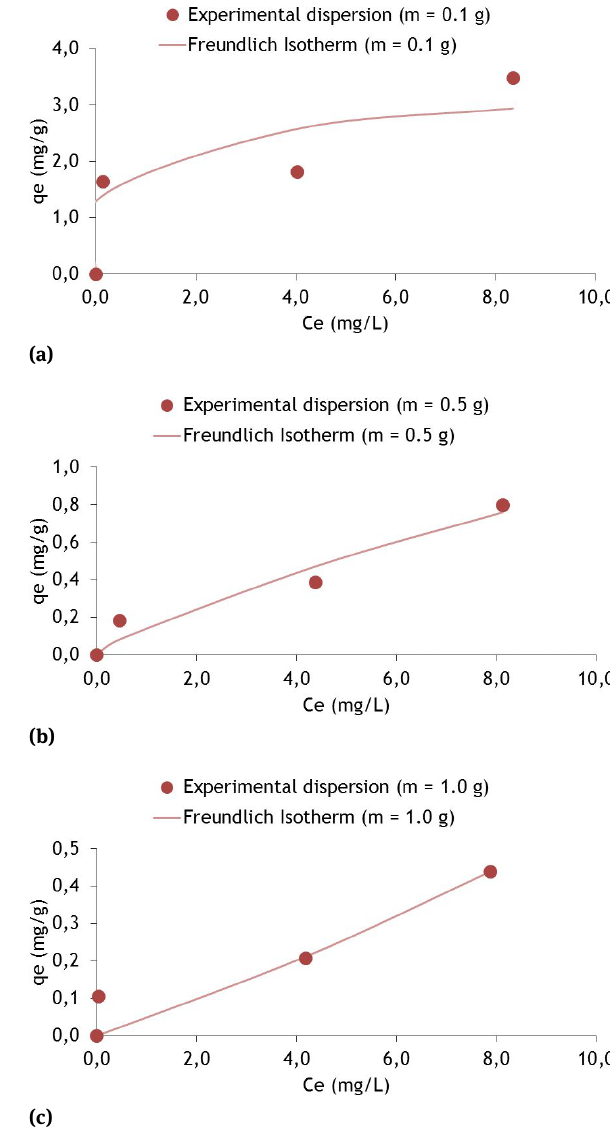
Figure 5: Sorption isotherms for the Freundlich model with Cr and soil masses of 0.1 g (a), 0.5 (b) and 1.0 g (c)